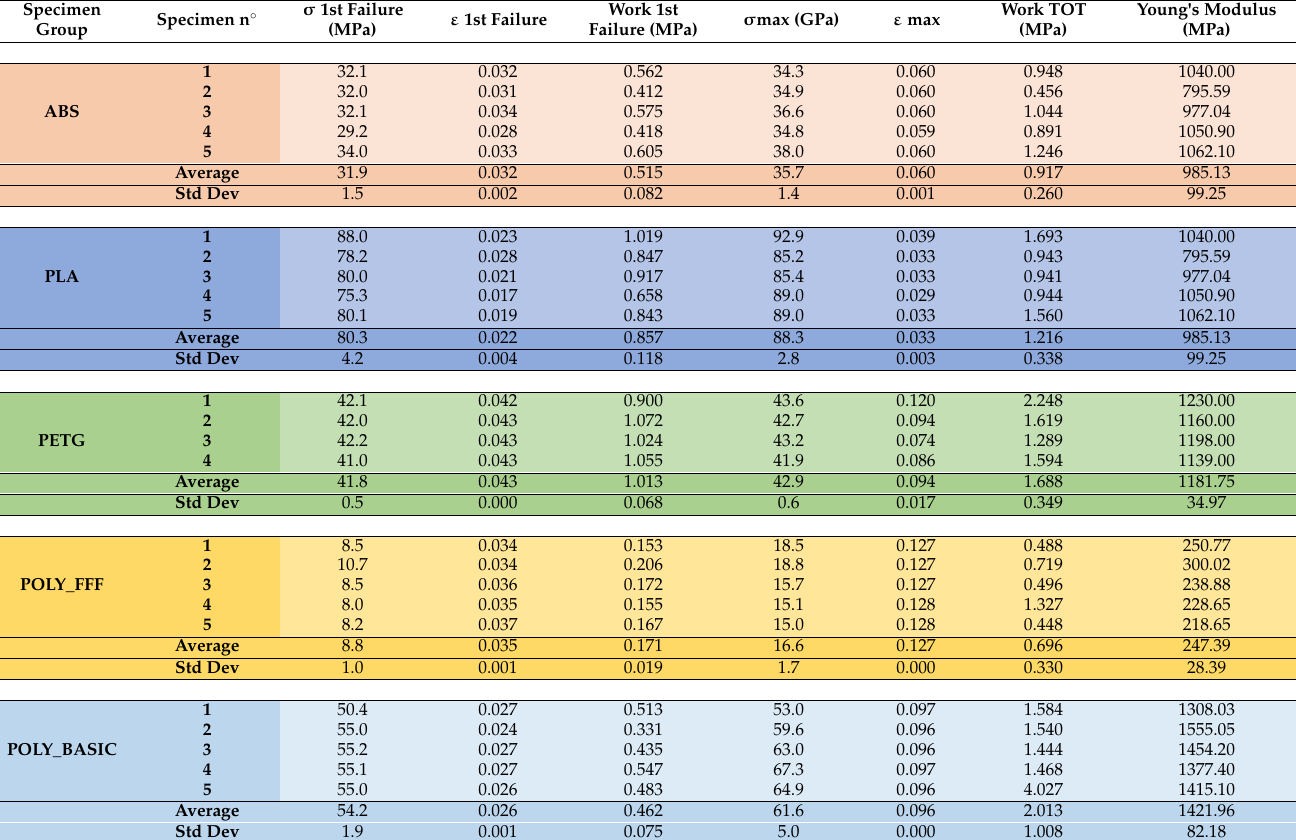
Figure 6. Stress/strain plots for the different sample groups. Table 4. Overview of all the relevant parameters obtained after the mechanical test and data processing from each sample group tested.